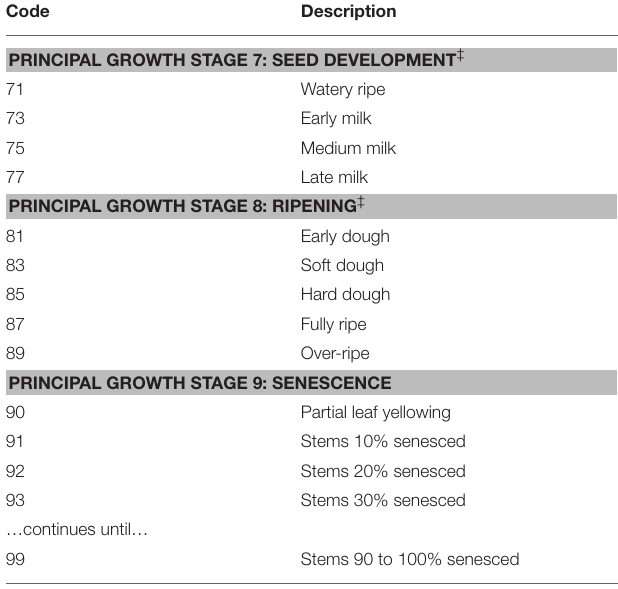
TABLE 2 | Miscanthus × giganteus morphological development stages according to the BBCH